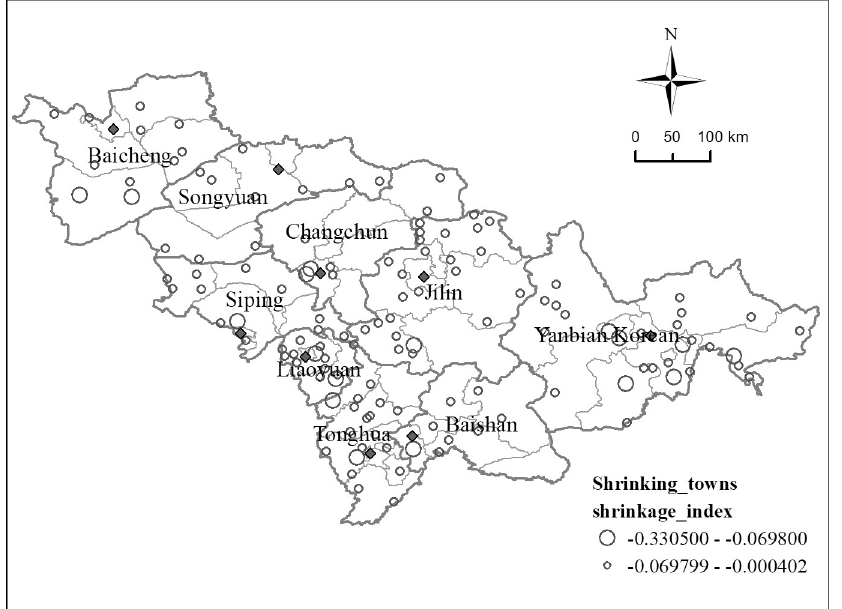
Fig 3. Spatial distribution of small towns shrinkage in the Jilin